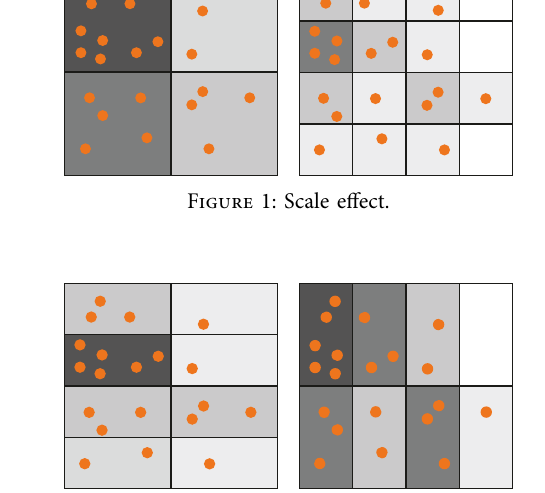
Figure 2: Zoning